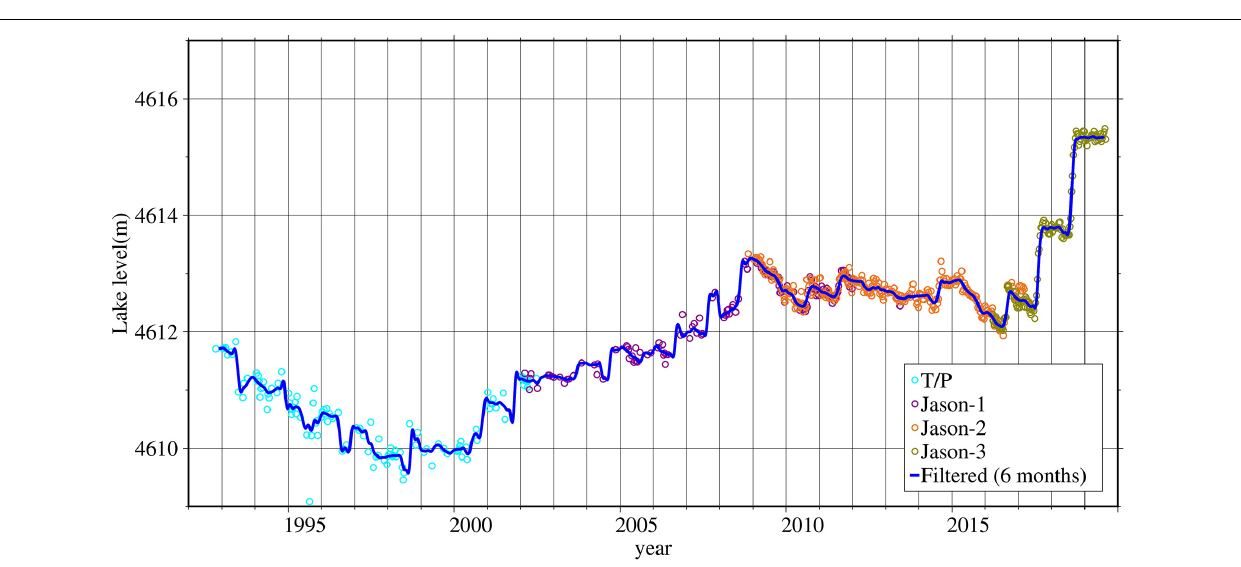
FIGURE 7 | Time series of lake level in Zhari